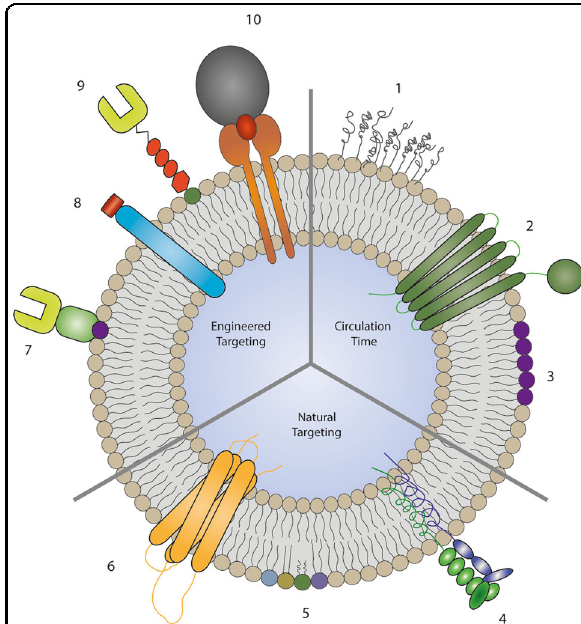
Fig. 1 Naturally occurring or arti fi cial features of EVs that alter the circulation time and targeting. The addition of polyethylene glycol (1) increases the circulation time 79 , the presence of CD47 47 (2) inhibits uptake and clearance from the circulation by macrophages, while PS 58 (3) is recognized by macrophages, leading to increased clearance. The integrin (4), lipid (5), and tetraspanin (6) compositions of EVs in fl uence their natural targeting properties. These targeting properties are altered by the addition of targeting moieties anchored via the phosphatidylserine-binding C1C2 domains of lactadherin 82 (7), the expression of lysosome-associated membrane protein 2 fusion proteins 38 (8), glycosylphosphatidylinositol-anchored targeting moieties 81 (9), and transferrin-conjugated magnetic particles bound to transferrin receptor expressed on EVs 93